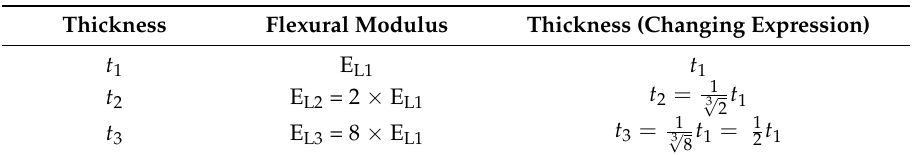
Table 3. Thickness